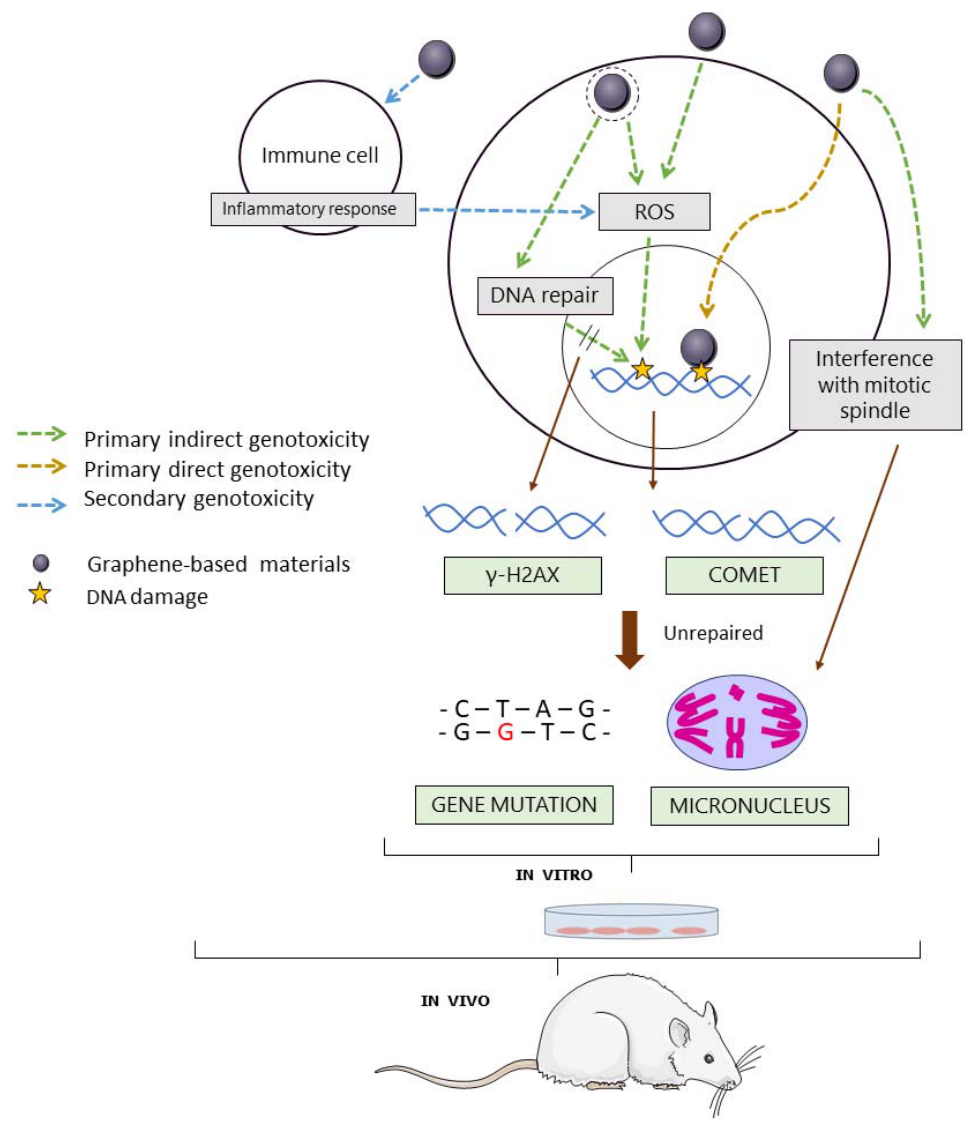
Figure 2. Genotoxic mechanisms of action of graphene-based materials, their genotoxic effects, and the in vitro and in vivo assays to detect them.